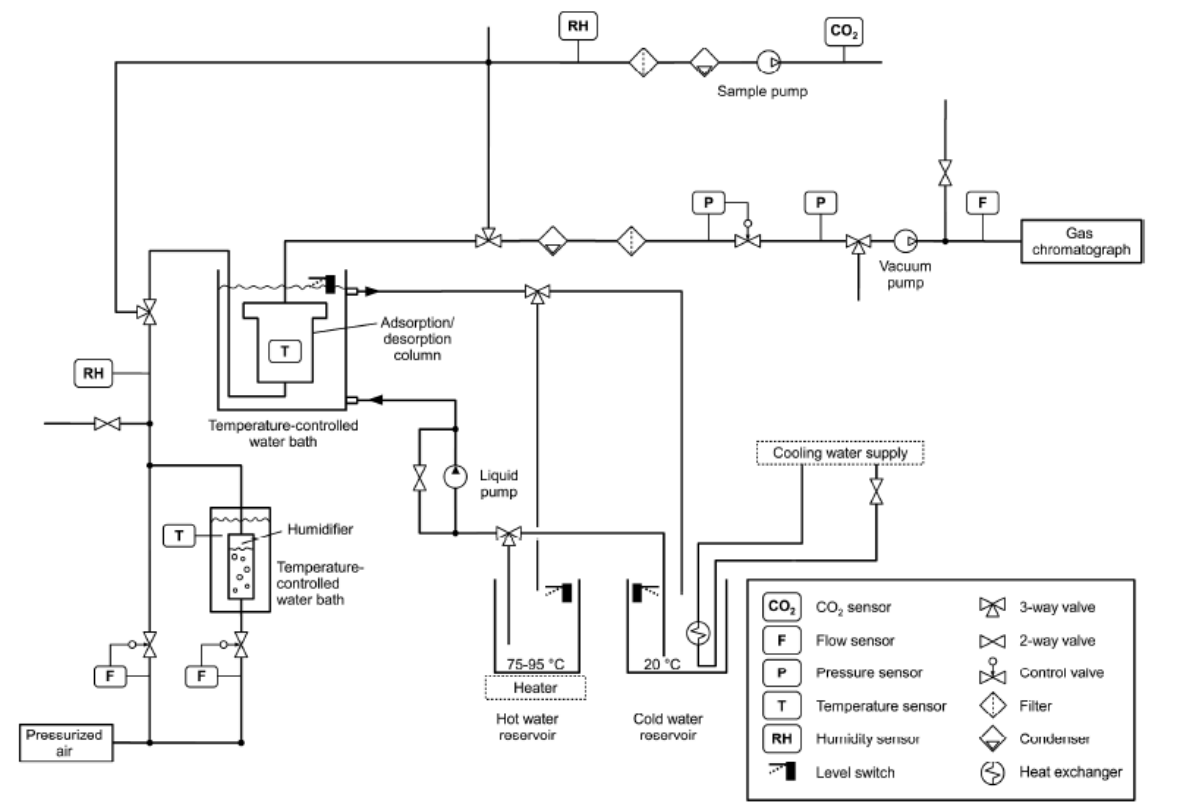
Figure 2 . Diagram of the experimental setup used for the validation of the mathematical model [74] .